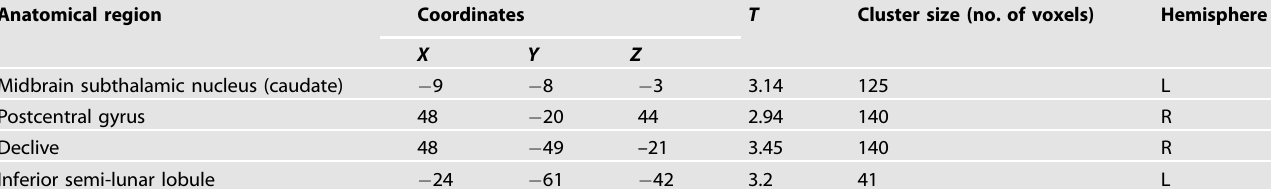
Table 2. Clusters that showed a signi fi cant increase in activation in response to smoking-related cues at baseline (smoking-related cues > neutral cues).